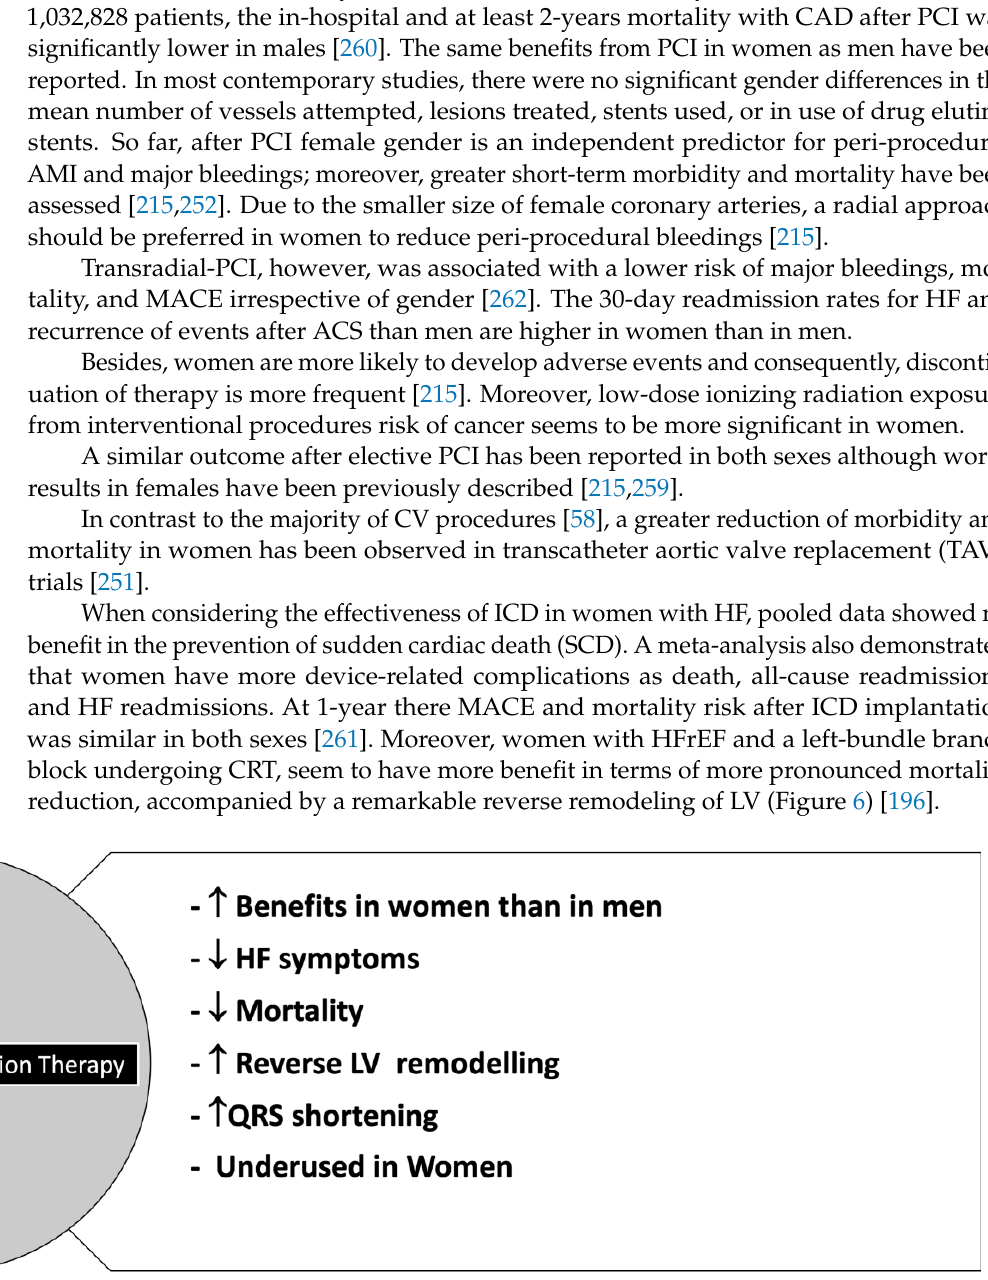
Figure 6. CRT in Women. Abbreviations: HF: Heart Failure; LV: left Ventricle.